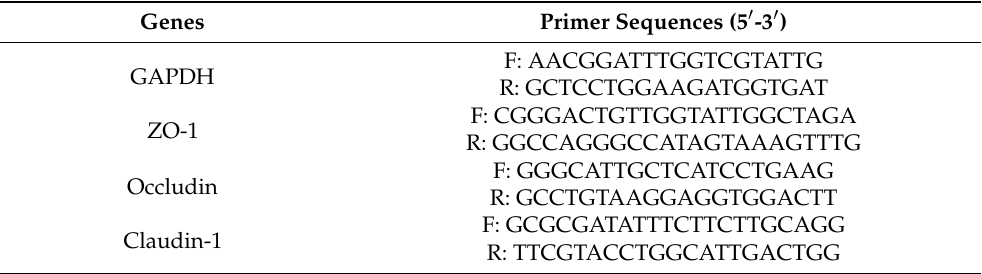
Table 1. Primer sequences used for